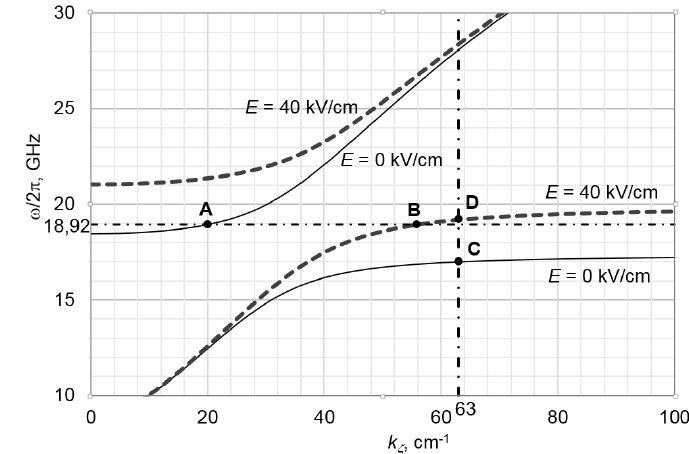
Fig.3. The dispersion characteristic of the HEMSW for two values of the applied electric field 0 kV/cm and 40